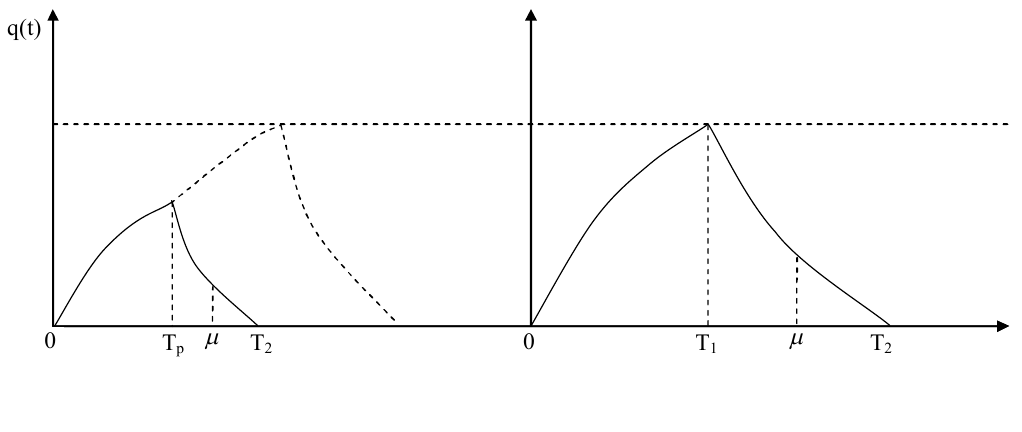
Fig. 1. Production system with lost